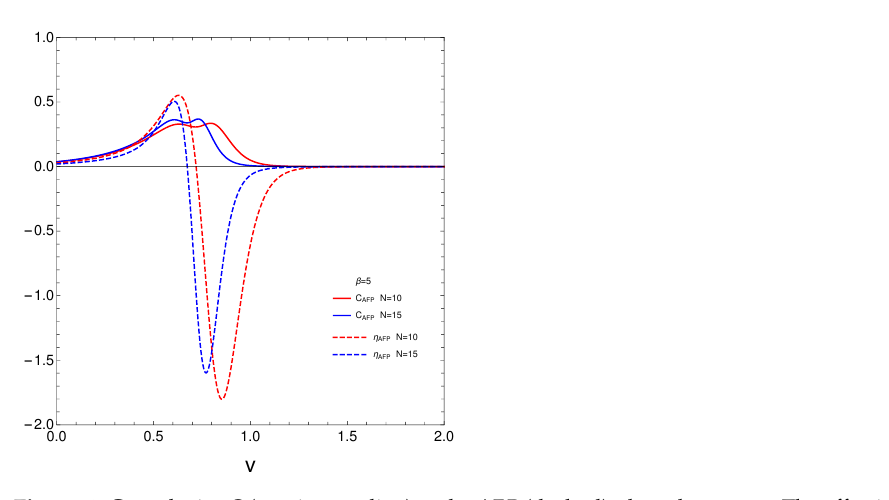
Figure 3. Critical v values versus N . Note that N > 250 does not make sense in a nuclear context.